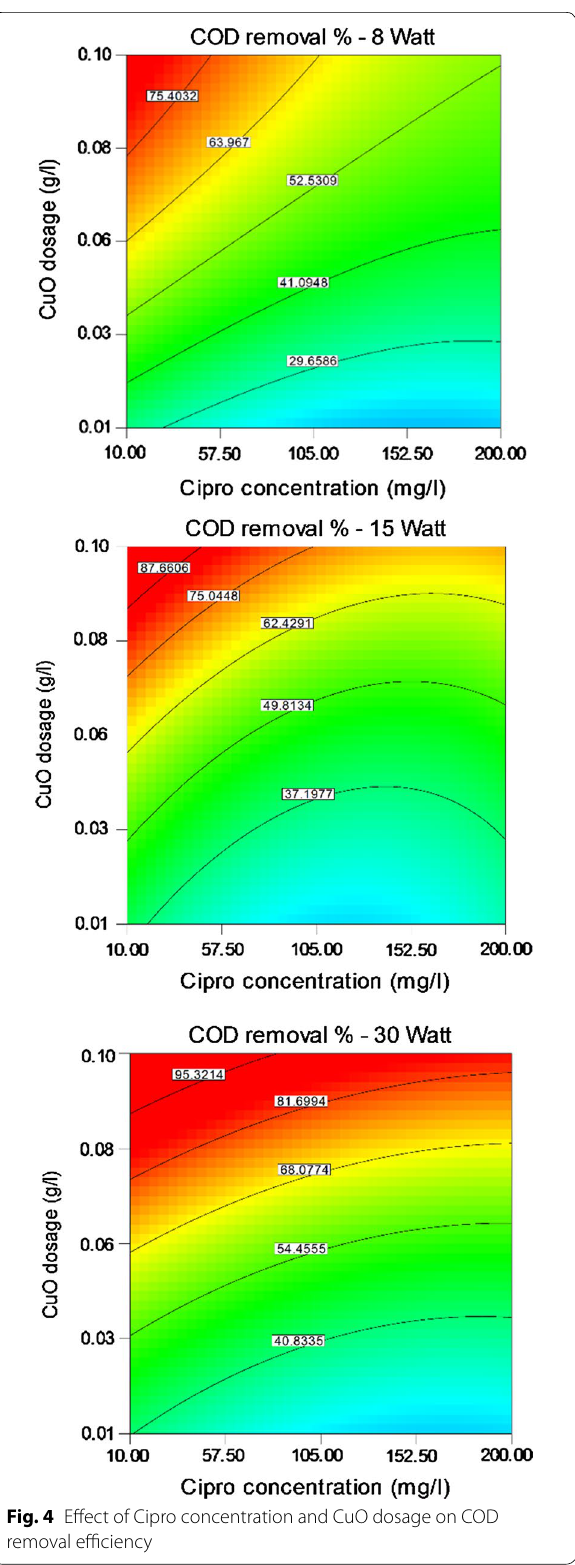
Fig. 4 Effect of Cipro concentration and CuO dosage on COD removal